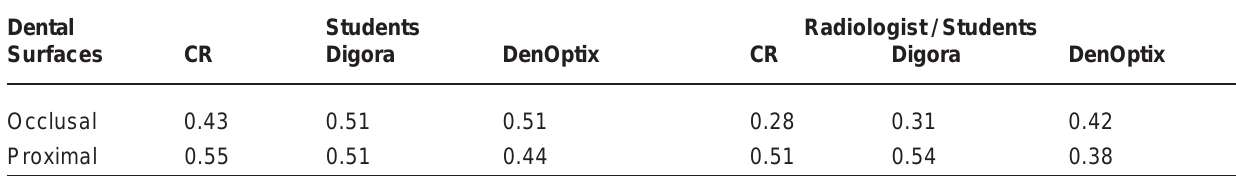
TABLE 1- Values of the Kappa test for the agreement between students and between students and radiologist